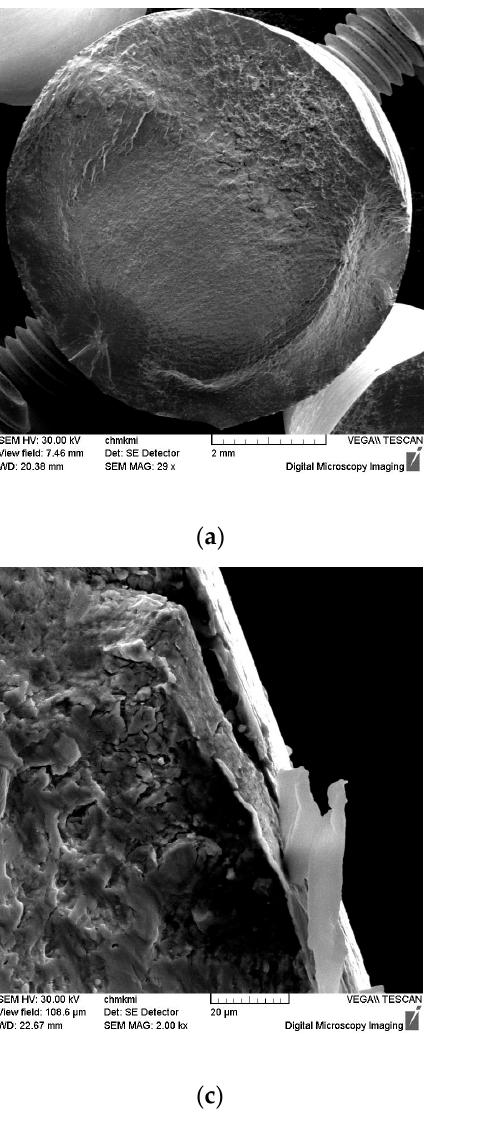
delamination of the strengthened surface layer ( c ) and final fracture with area of finer dimples in the